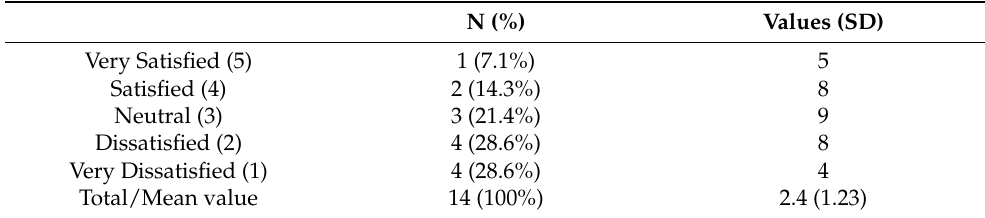
Table 6. Respondents’ Perceptions: are they satisfied with the water supply in Mykonos (Q10). N (%) Values (SD) Very Satisfied